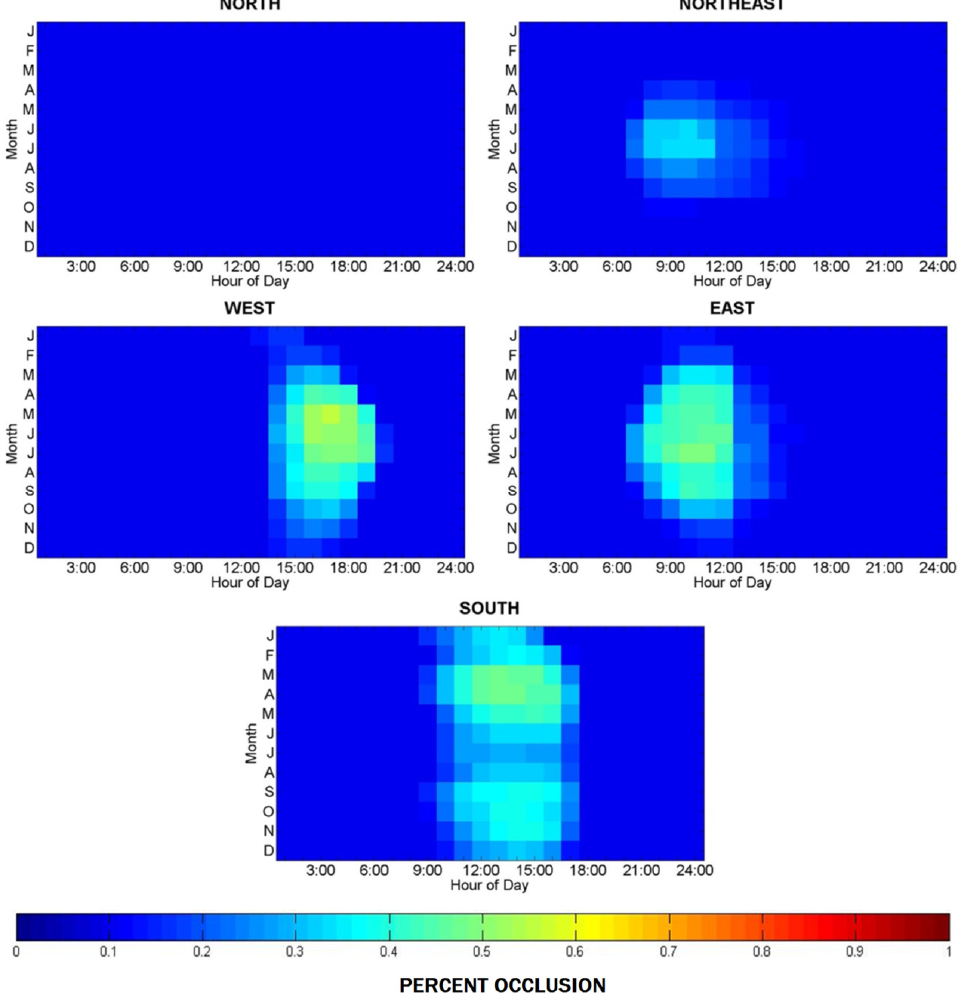
Figure 17. Hourly average percent occlusion for second floor (Blindswitch